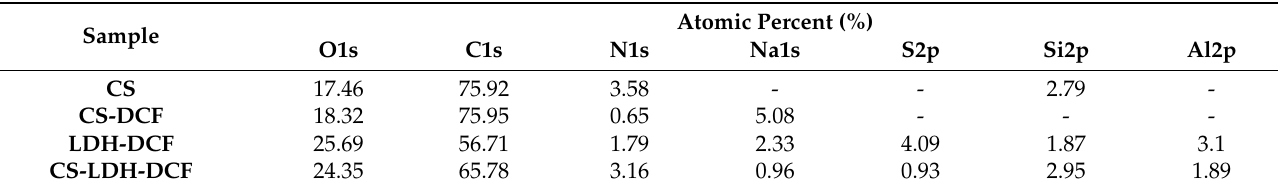
Figure 4. X-ray photoelectron spectroscopy (XPS) of CS, CS-DCF, LDH-DCF and CS-LDH-DCF. Table 1. XPS elemental data analysis.